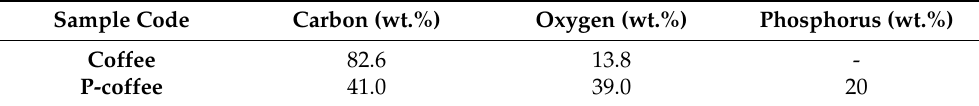
groups in aliphatic esters. For the P-coffee sample, the absorption peak of P=O was situ-